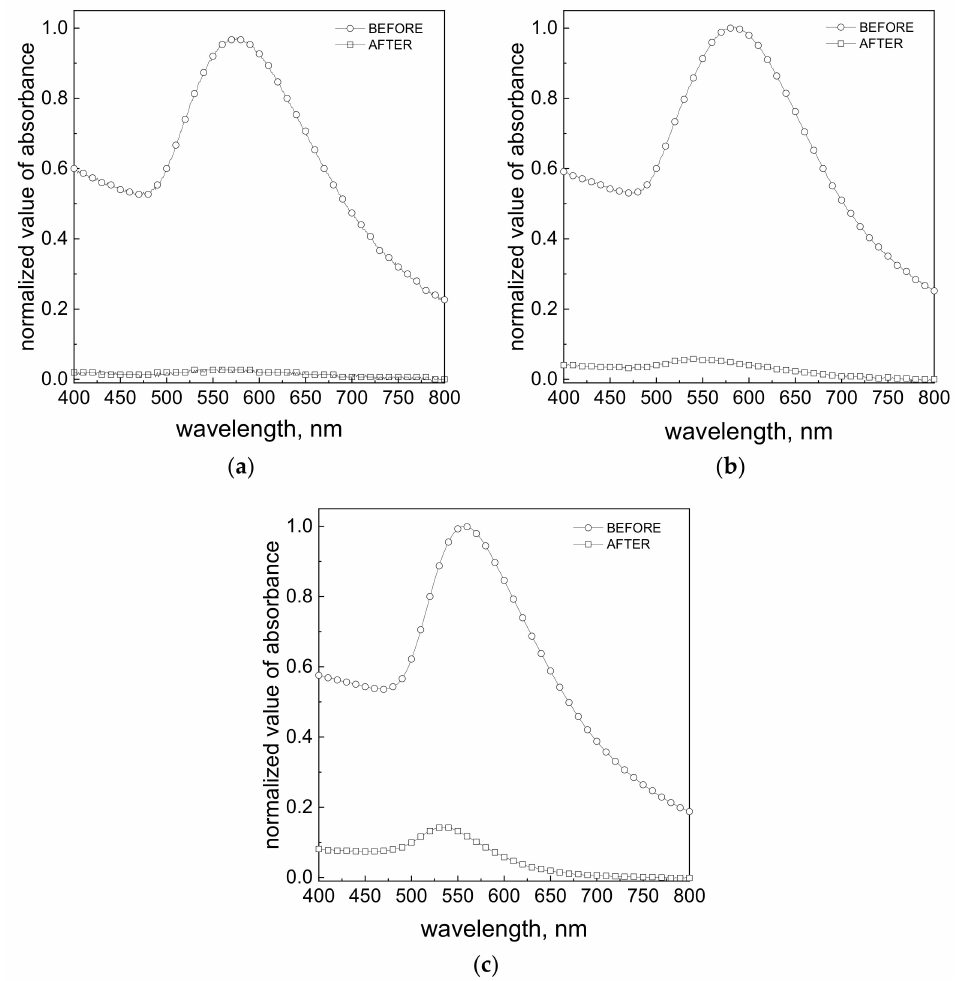
Figure 7. Absorption spectra of colloidal gold obtained in a result of reduction reaction of Au(III) ions with reductant. Experimental conditions: C 0, Au(III) = 0.05 mM, C 0, H2Asc = 0.9 mM ( a ); C 0, Au(III) = 0.15 mM, C 0, H2Asc = 0.9 mM ( b ); C 0, Au(III) = 0.3 mM, C C 0, H2Asc = 0.9 mM ( c ), all colloids are without